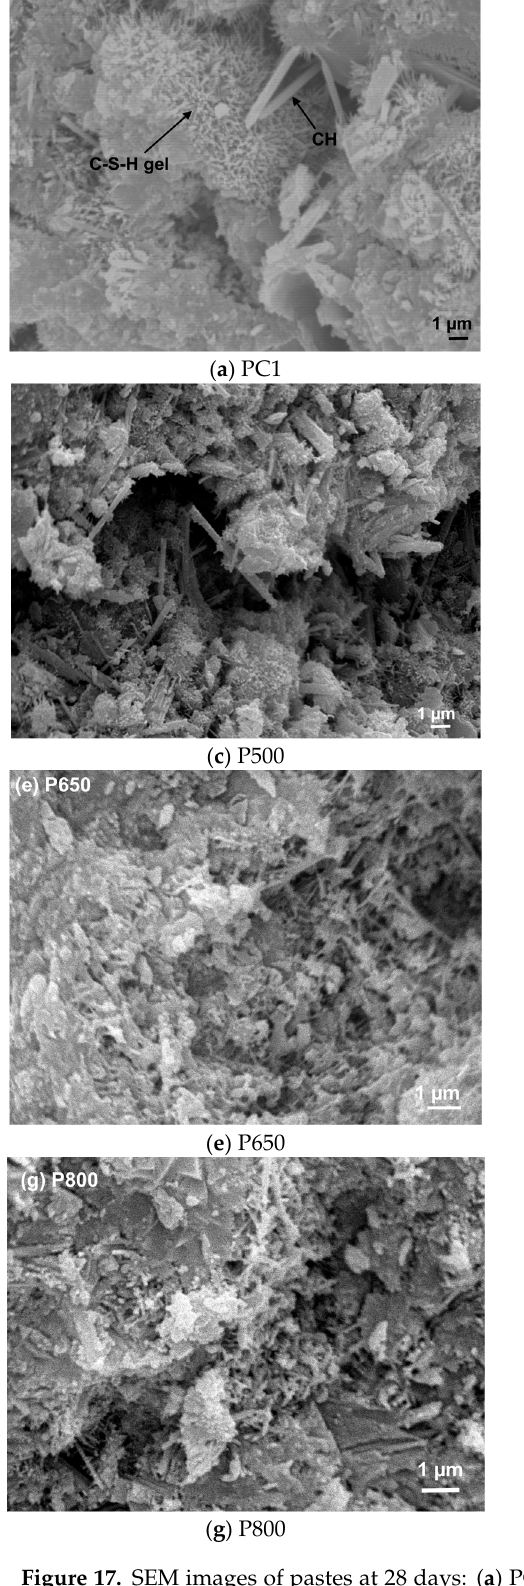
Figure 17. SEM images of pastes at 28 days: ( a ) PC1; ( b ) P450; ( c ) P500; ( d ) P600; ( e ) P650; ( f ) P700; ( g ) P800 and ( h ) P900.